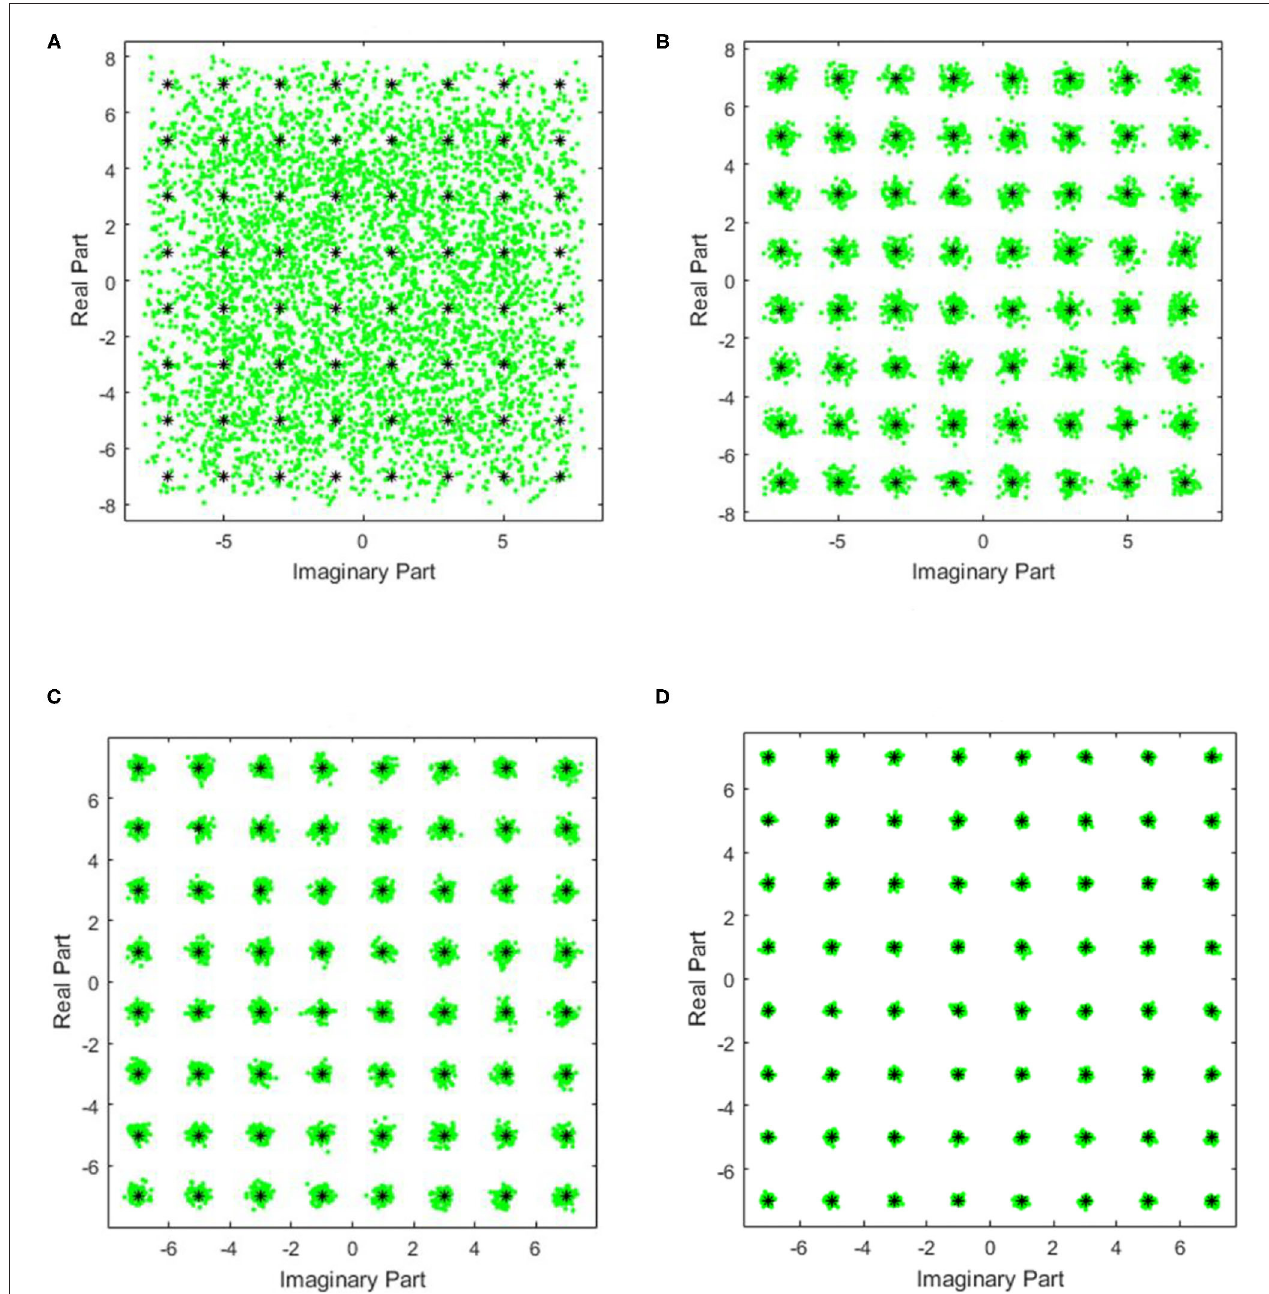
FIGURE 3 | The equalizer input signal diagram and the output constellations of all algorithms. (A) The equalizer input signal diagram and the output constellation diagram of (B) MCMA, (C) Concurrent MCMA-DD, and (D) Concurrent MCMA-DD with BB.